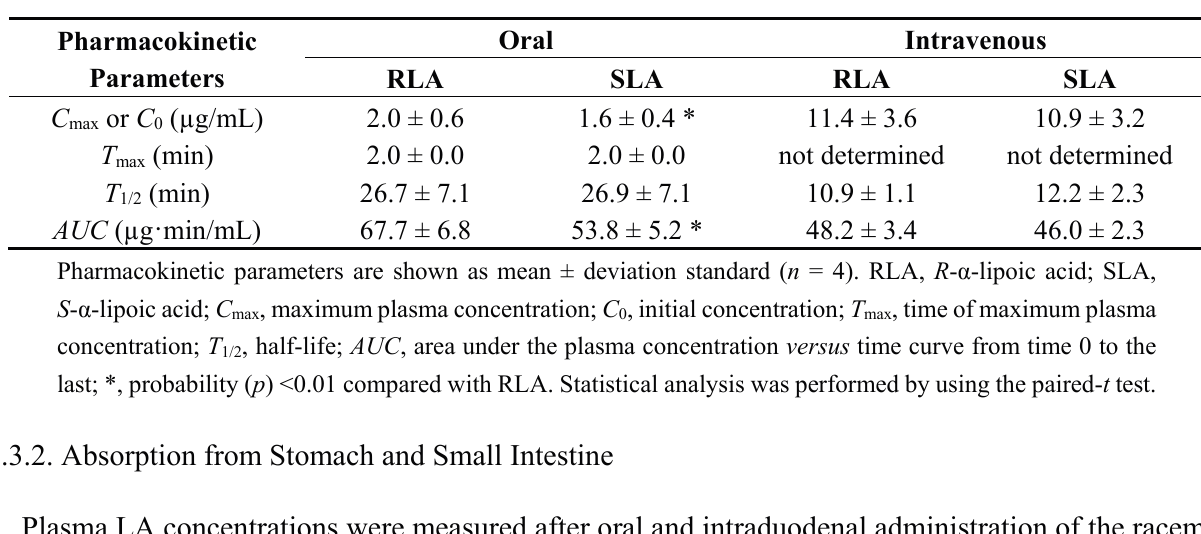
Table 2. Pharmacokinetic parameters of α -lipoic acid after oral and intravenous administration of the racemic mixture to rats.